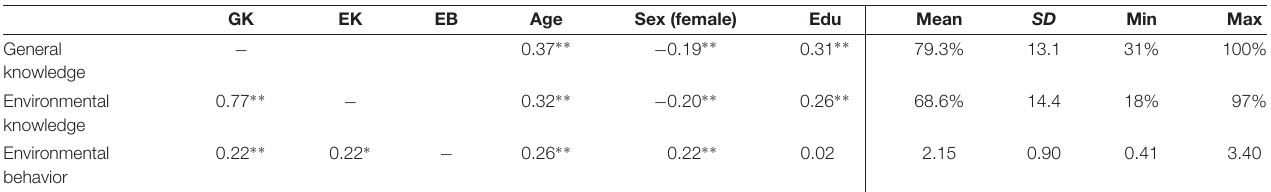
TABLE 4 | Zero order bivariate correlations and descriptive results for environmental and general knowledge and environmental